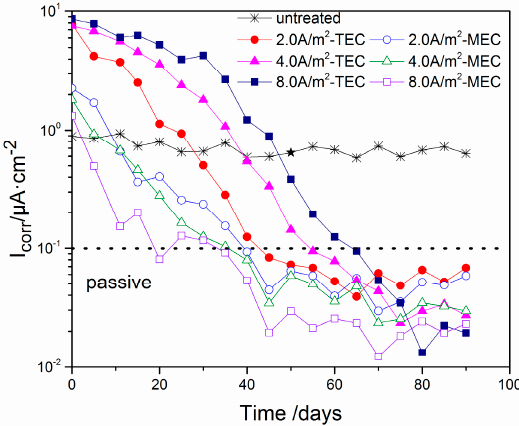
Figure 11. Changes of the steel corrosion current density with time (untreated, after the TEC treatment and the MEC treatment).